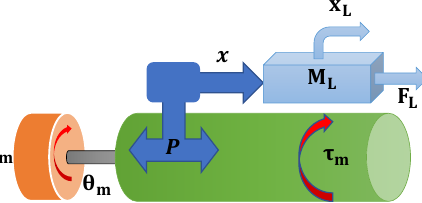
Figure 4. Transformation of rotational motion to linear motion. Where the motor angle is represented by Formula